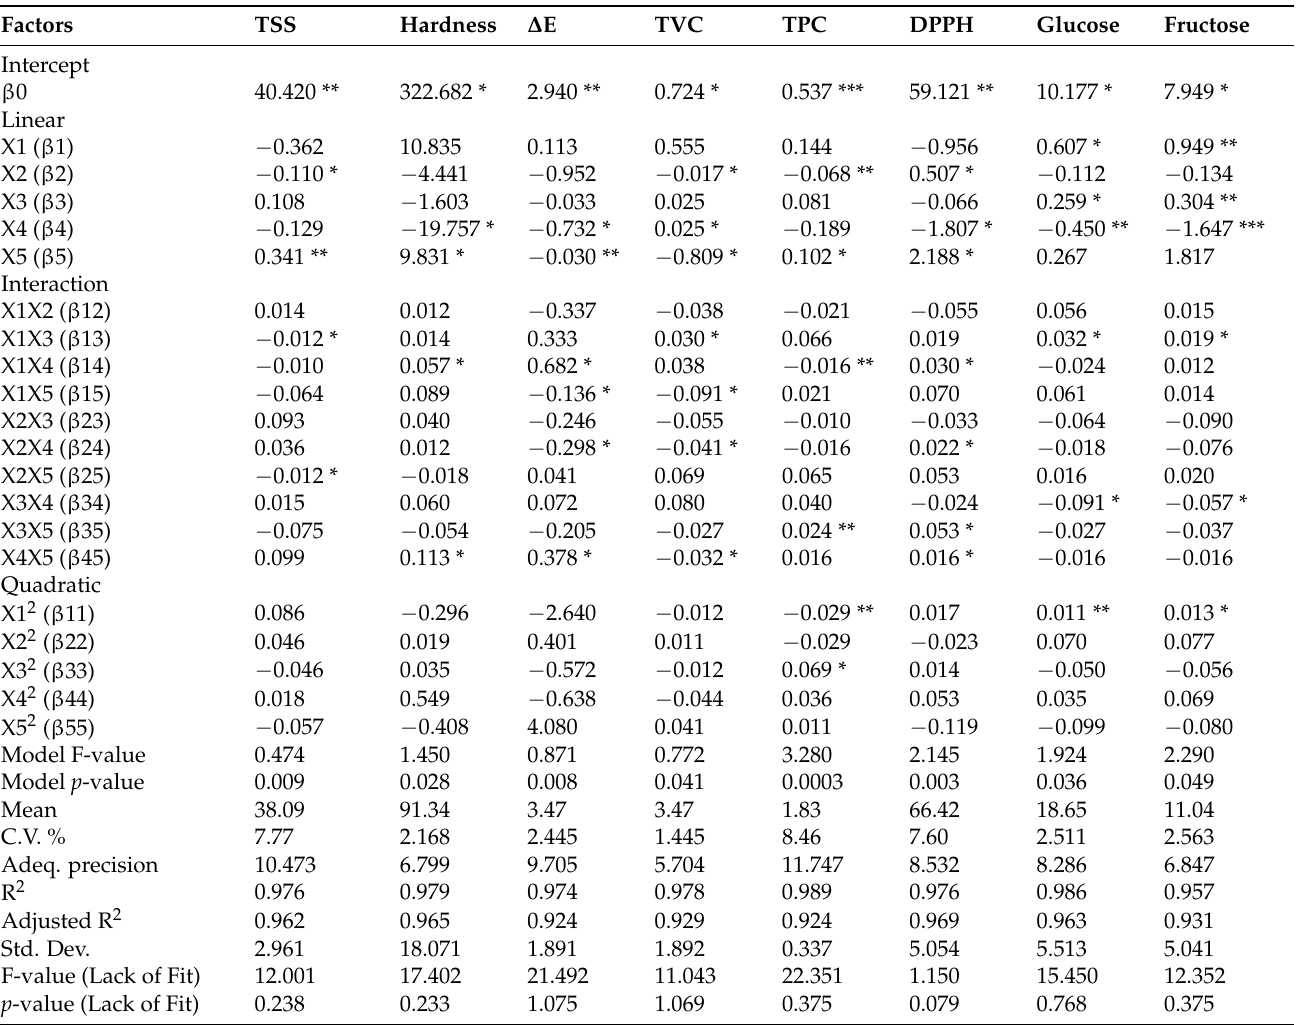
Table 2. PEF Regression coefficients for process variables and product